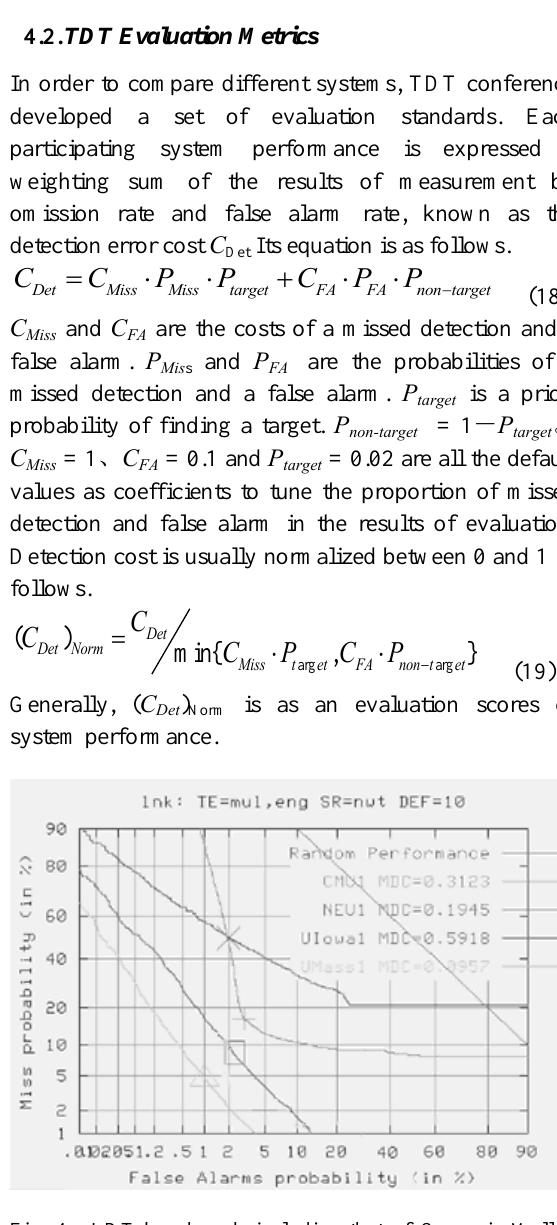
Fig. 4. LDT benchmark including that of Carnegie Mellon University. Our results are better than that of TDT